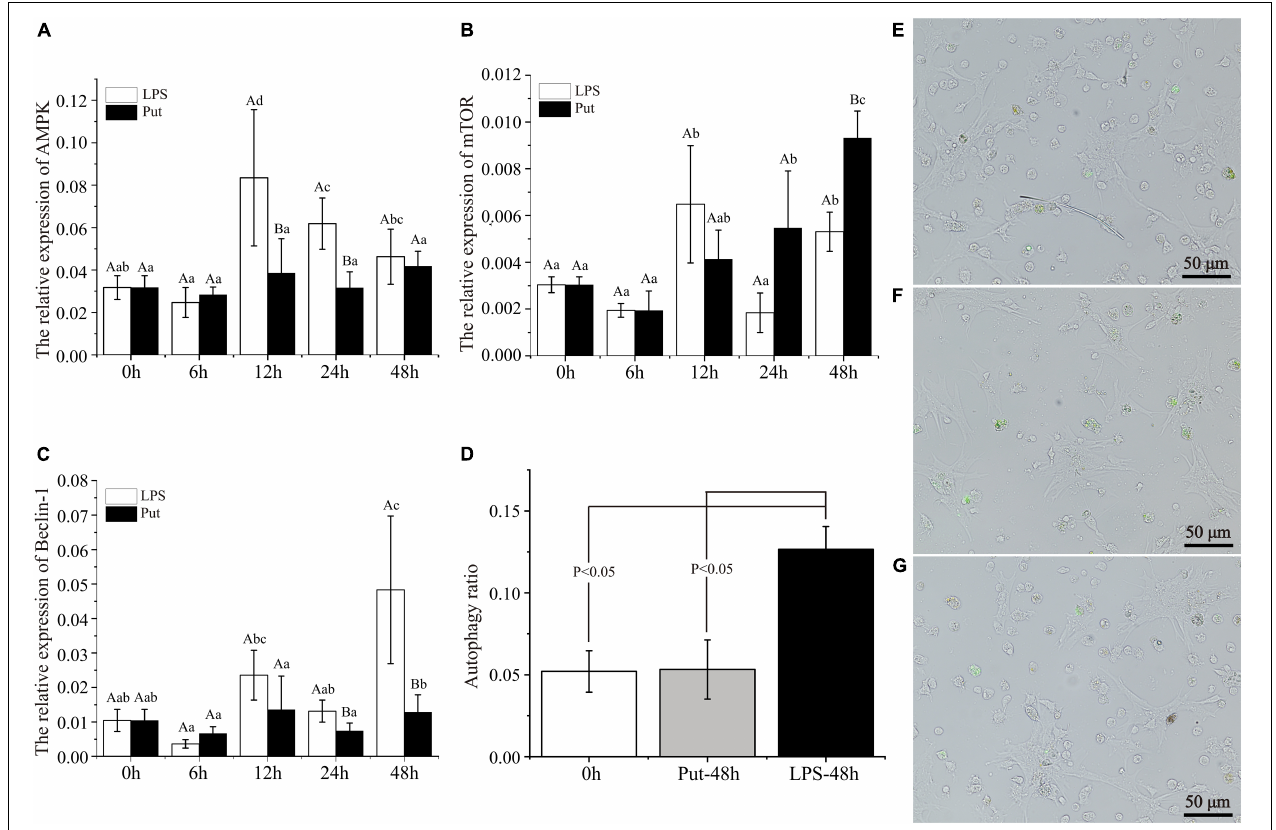
FIGURE 6 | Putrescine treatment significantly inhibited hemocyte autophagy in pearl oysters. (A–C) mRNA expression of AMP-activated protein kinase (AMPK), mammalian target of rapamycin (mTOR), and Beclin-1 in hemocytes was analyzed. Values are shown as mean ± SE ( N = 5). Lowercase letters represent differences at different time points in the same groups, and capital letters represent differences in the different groups at same time points. (D–G) Level of autophagy in hemocytes was detected via the monodansylcadaverine (MDC) method. Green fluorescence represents a positive signal. Lipopolysaccharide (LPS) group, PBS_LPS; Put group, Put